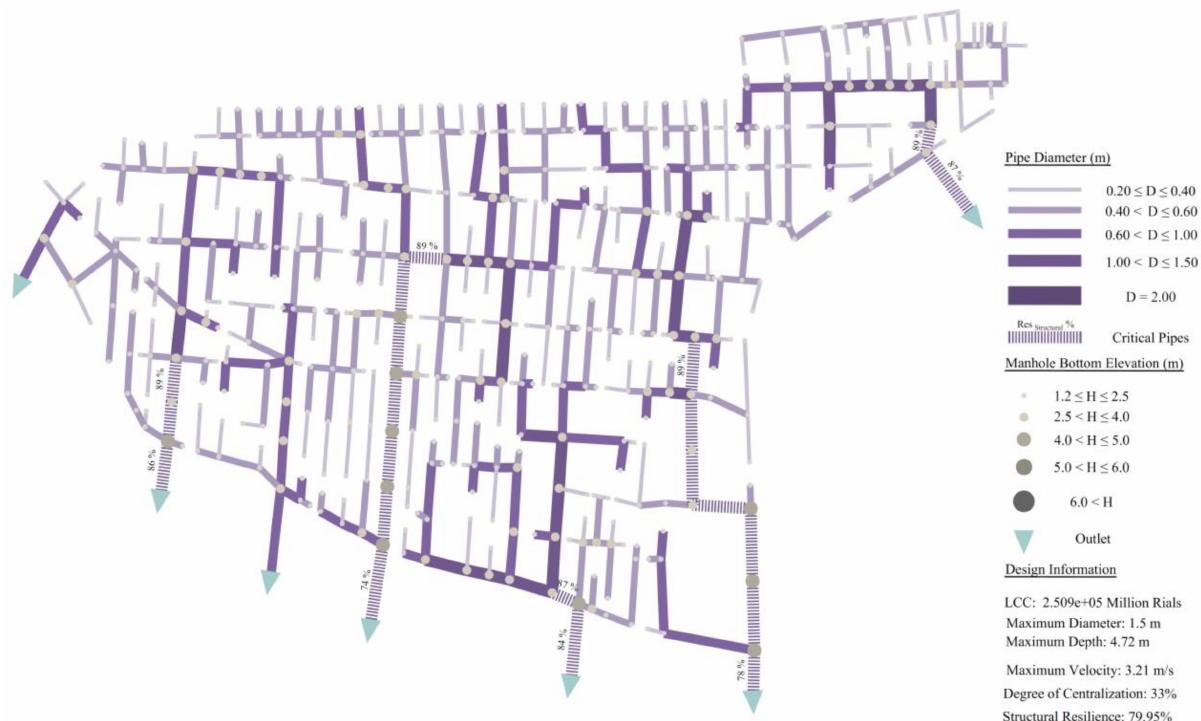
Figure 10. Design 4 (LCC = 250,900 M. Rials and DC =